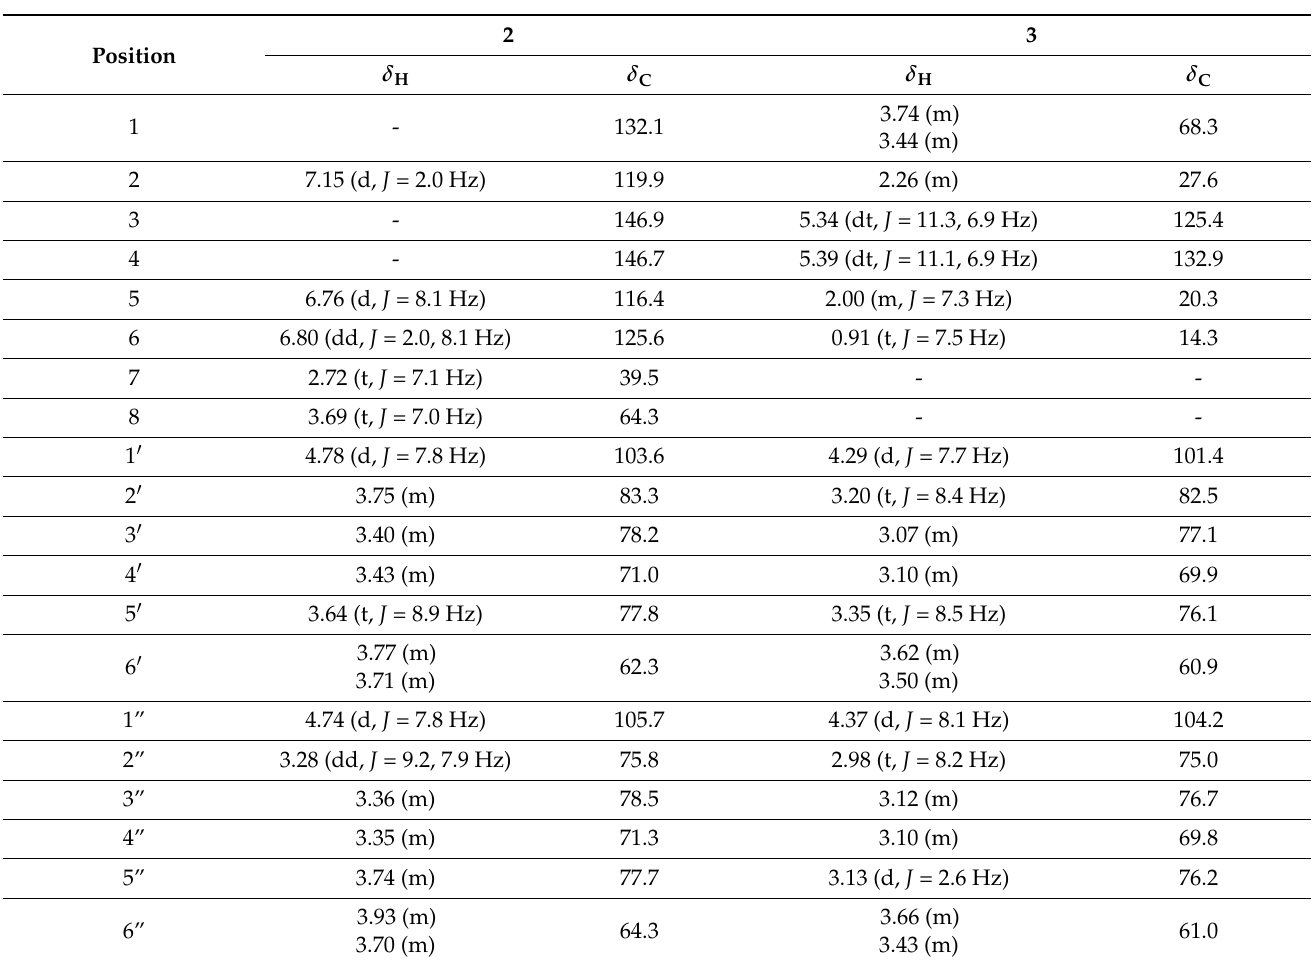
Table 2. 1 H (600 MHz) and 13 C (150 MHz) NMR data of compounds 2 in CD 3 OD, 3 in DMSO ( δ in ppm, J in